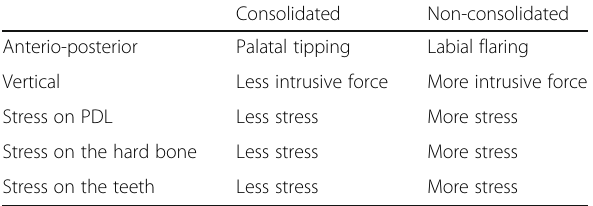
Consolidated Non-consolidated Anterio-posterior Labial